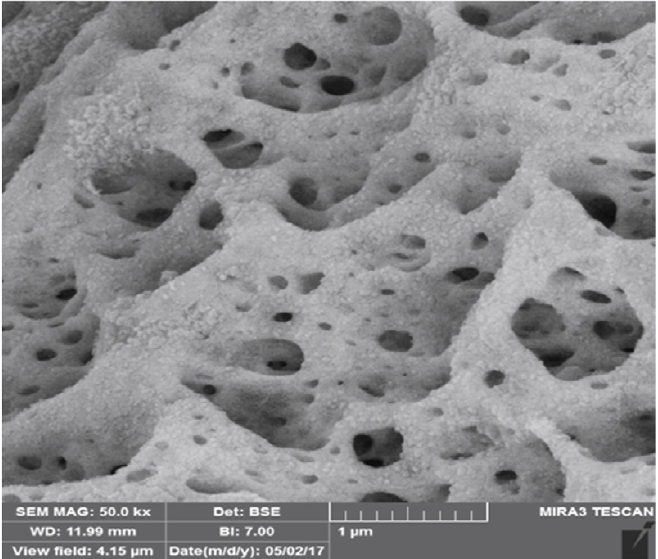
Fig. 1. TEM image of CeAlO nanoparticle powders synthesized by combustion 3